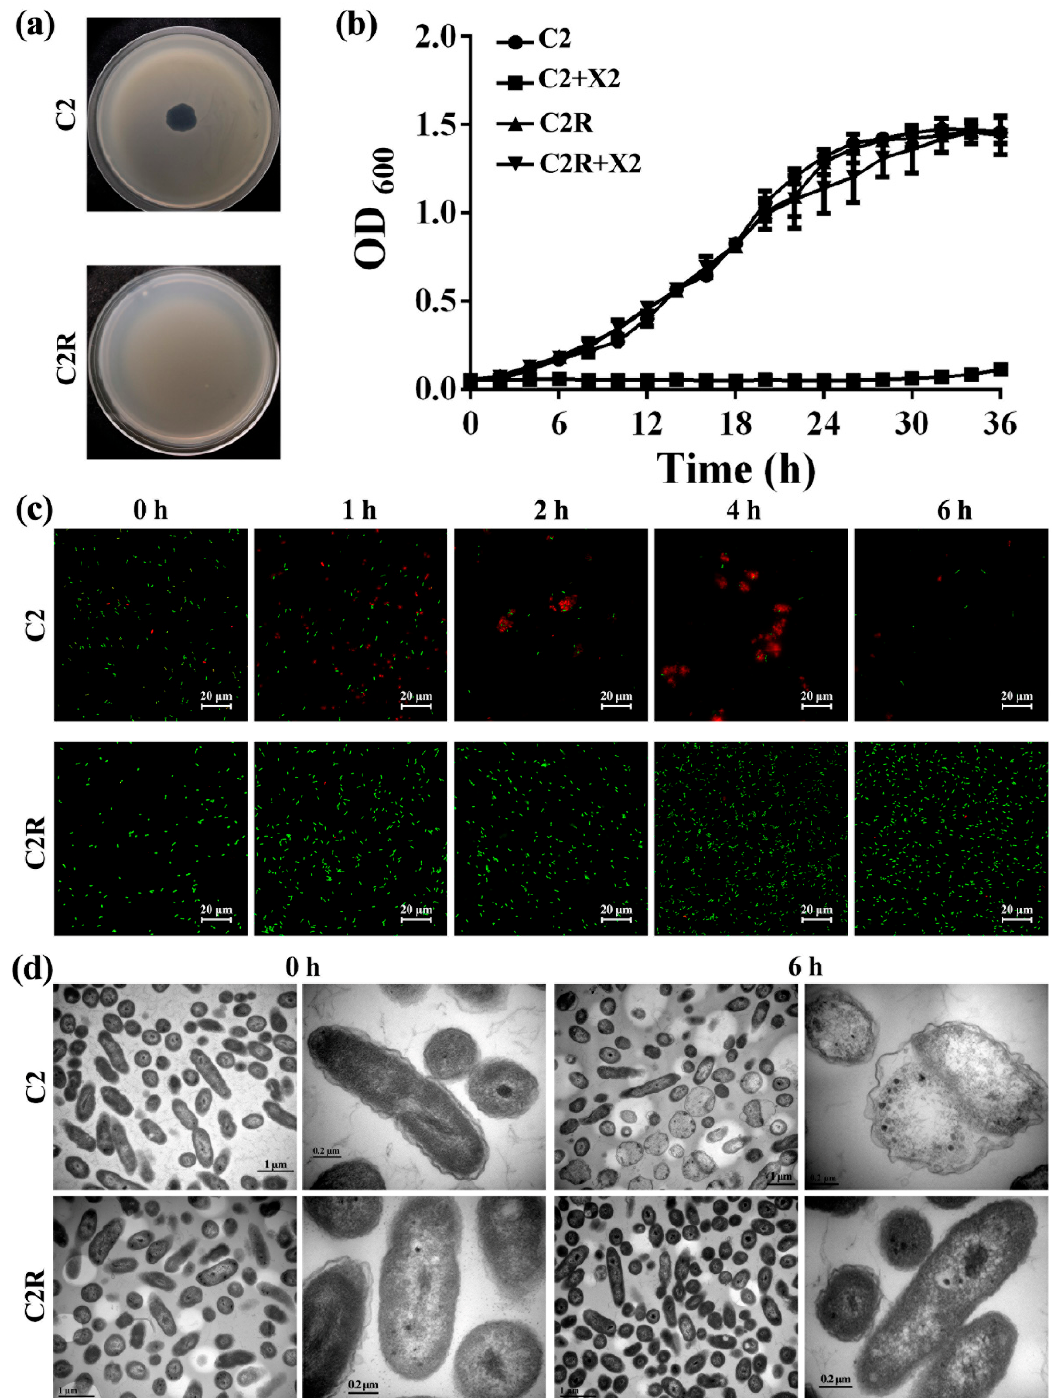
Figure 1. Resistance of Xoo spontaneous mutant C2R to phage infection. ( a ) Spot assays on Xoo wild-type strain C2 and mutant C2R by spotting 2 µ L of phage solutions onto freshly bacterial lawns and then incubating overnight at 30 °C. ( b ) Bacterial growth curve of Xoo wild-type strain C2 and mutant C2R in presence or absence of phage X2. ( c ) Live/dead cell staining of Xoo wild-type strain C2 and mutant C2R after 0, 1, 2, 4 and 6 h incubation with phage X2. Red and green fluorescent represents dead and live bacteria, respectively. ( d ) TEM images of Xoo wild-type strain C2 and mutant C2R after 0 and 6 h incubation with phage X2.